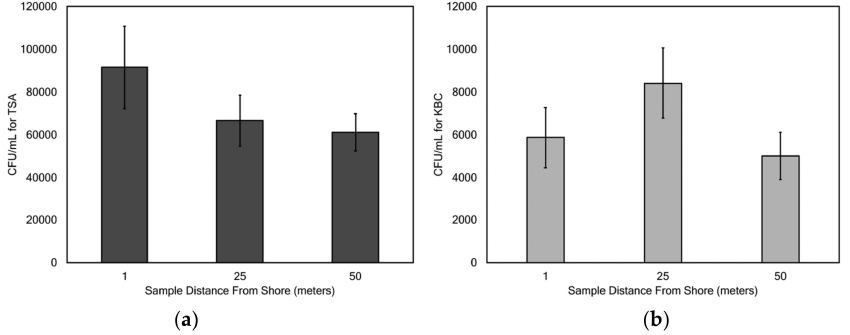
Figure 4. ( a ) Histogram of mean CFU/mL cultured on TSA agar media at the different distances from shore. Error bars represent the standard error. Values were calculated from counts obtained at each distance from shore (1, 25, and 50 m); ( b ) Histogram of mean CFU/mL cultured on KBC agar media at the different distances from shore. Error bars represent the standard error. Values were calculated from counts obtained at each distance from shore (1, 25, and 50